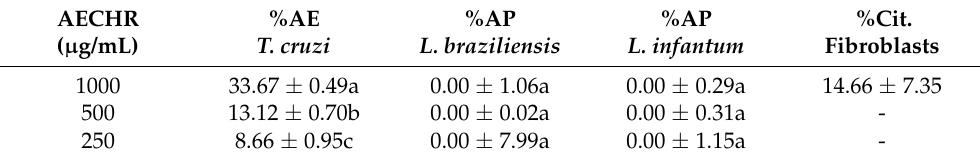
Table 4. Antiparasitic and cytotoxic effects of the Croton heliotropiifolius extract.